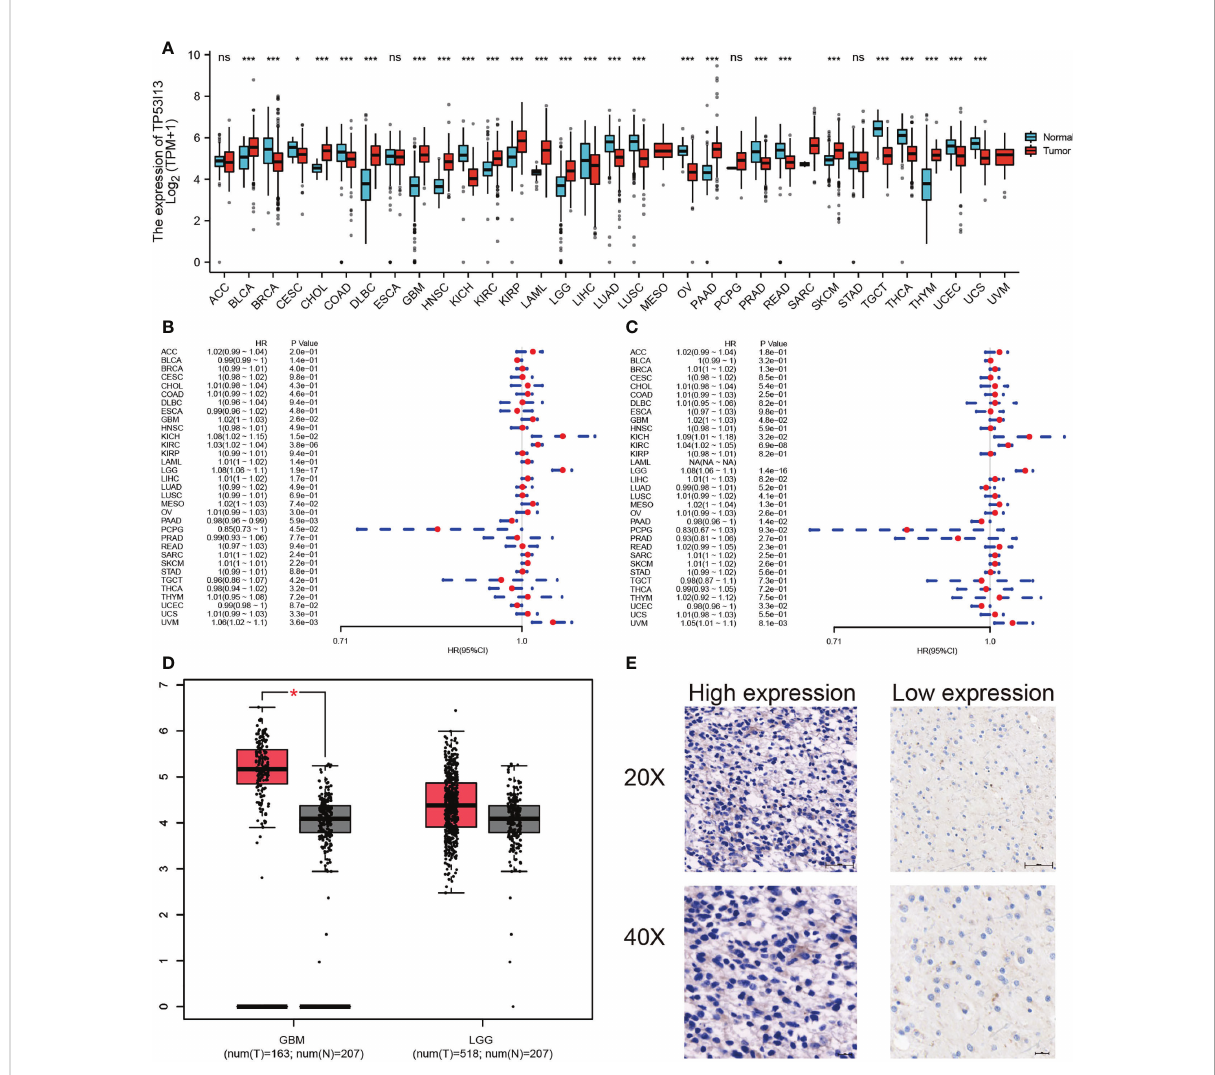
FIGURE 2 (A) Pan-cancer analysis of TP53I13 in different tumors based on GTEx and TCGA databases *, P<0.05; ***, P<0.001. (B) The hazard ratio for overall survival in 33 tumors expressing TP53I13 . (C) The hazard ratio for disease-speci fi c survival in 33 tumors expressing TP53I13 . (D) TP53I13 expression based on the GEPIA database. (E) Representative immunohistochemistry (IHC) analysis shows high and low TP53I13 expression. ns, no signi fi